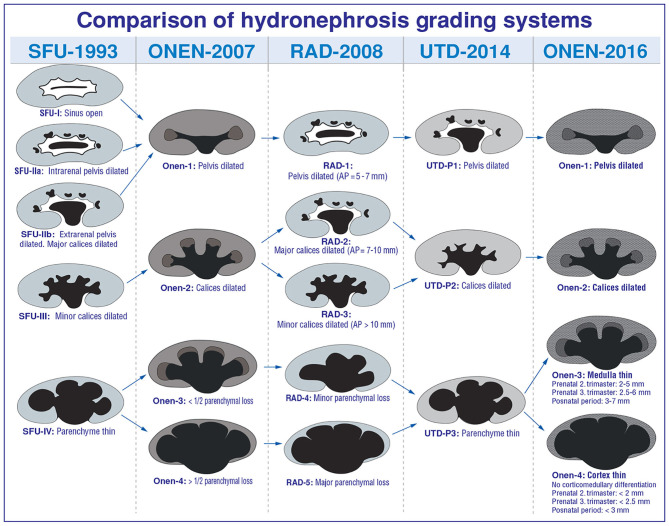
Comparison of hydronephrosis grading systems.